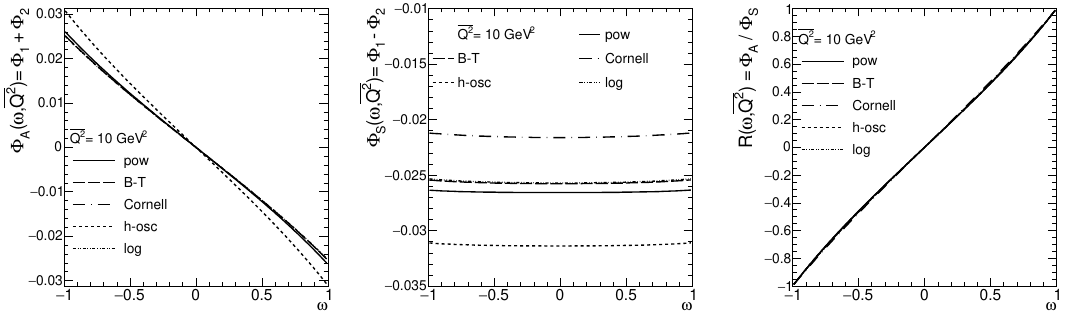
Figure 1 . Antisymmetric Φ A and symmetric Φ S form factors for γ ∗ γ ∗ → χ c (1 ++ ) as a function of the asymmetry of photon virtualities (left and middle panels) and the ratio of the Φ A / Φ S form factors again as a function of asymmetry of photon virtualities (right panel).